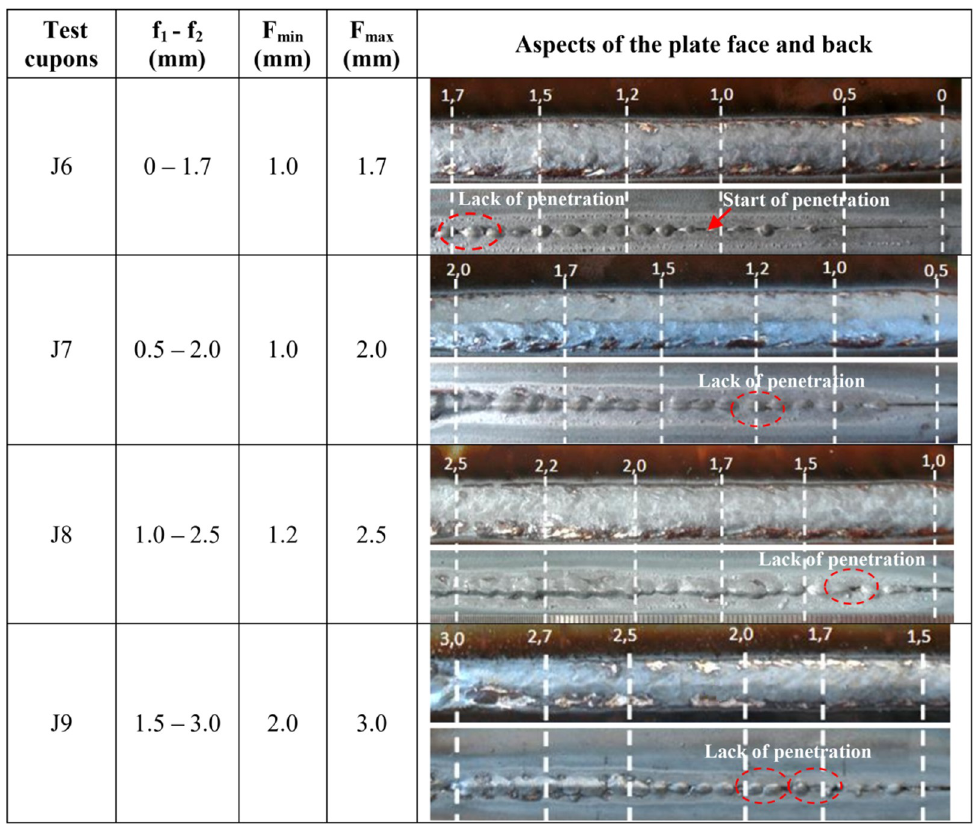
Figure 5. Quantification of the operational gap range for the experiment 2SB (switchback torch movement).